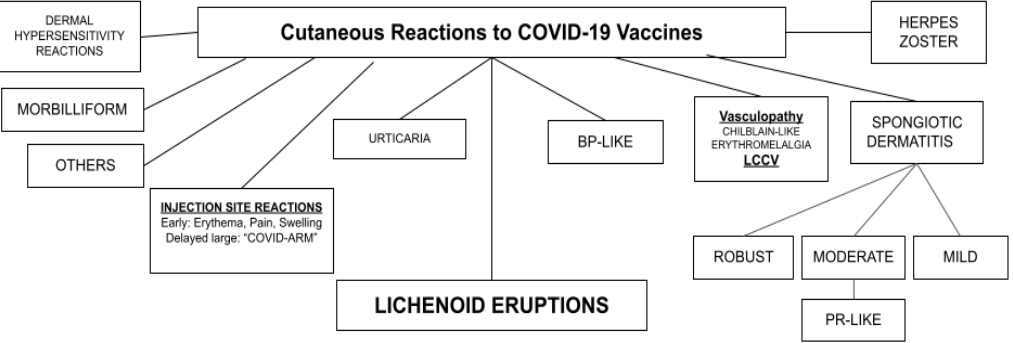
Figure 1. Cutaneous reactions to COVID-19 vaccines. BP, bullous pemphigoid; LCCV, leucocytoclastic vasculitis; PR, pityriasis